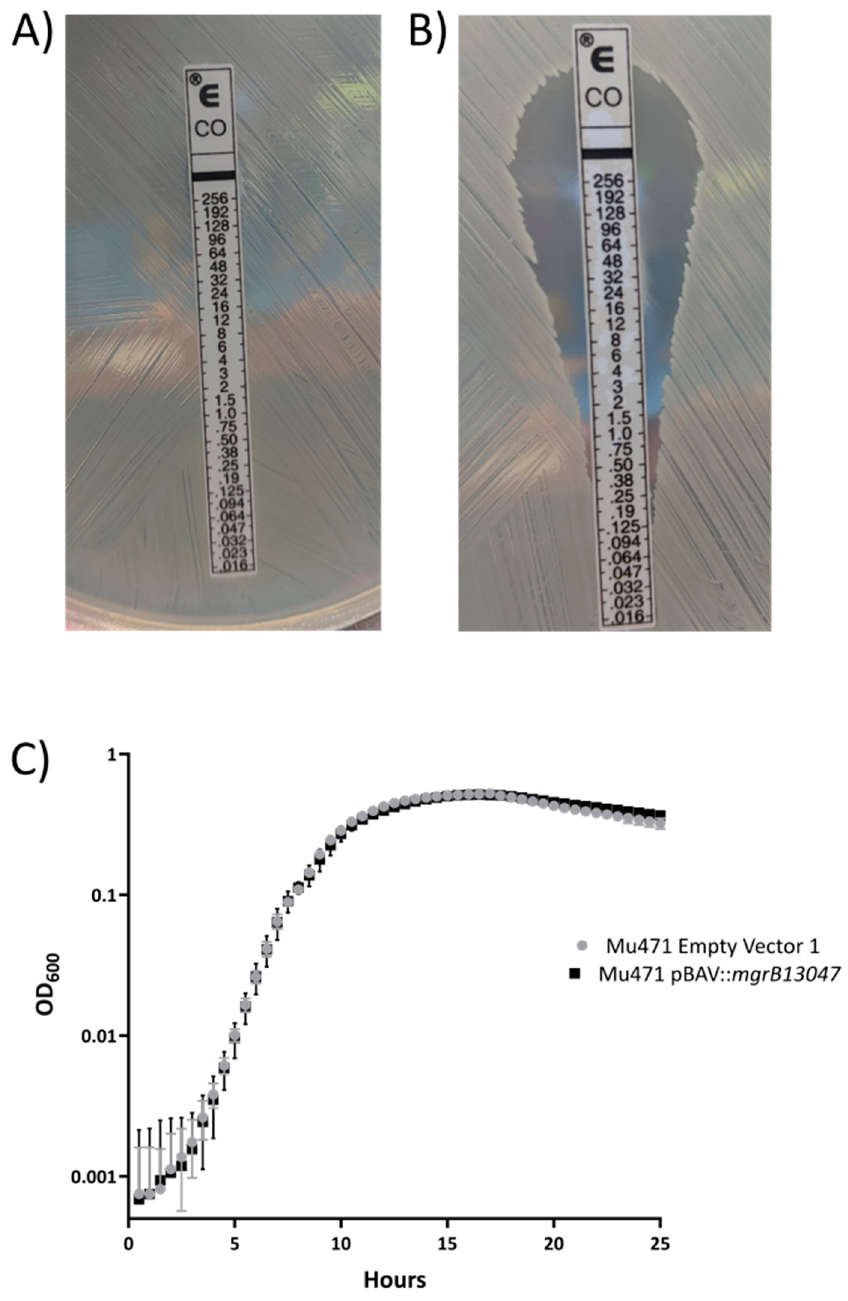
Figure 1. Mu471 exhibits high-level colistin resistance in the absence of a growth delay. ( A ) Etest